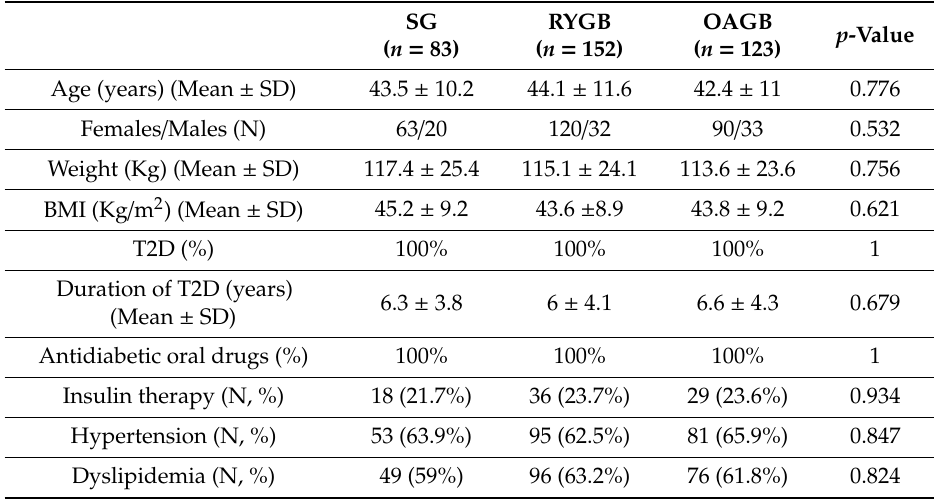
Table 1. Distribution of age, gender, preoperative anthropometric measures and distribution of comorbidities between groups.